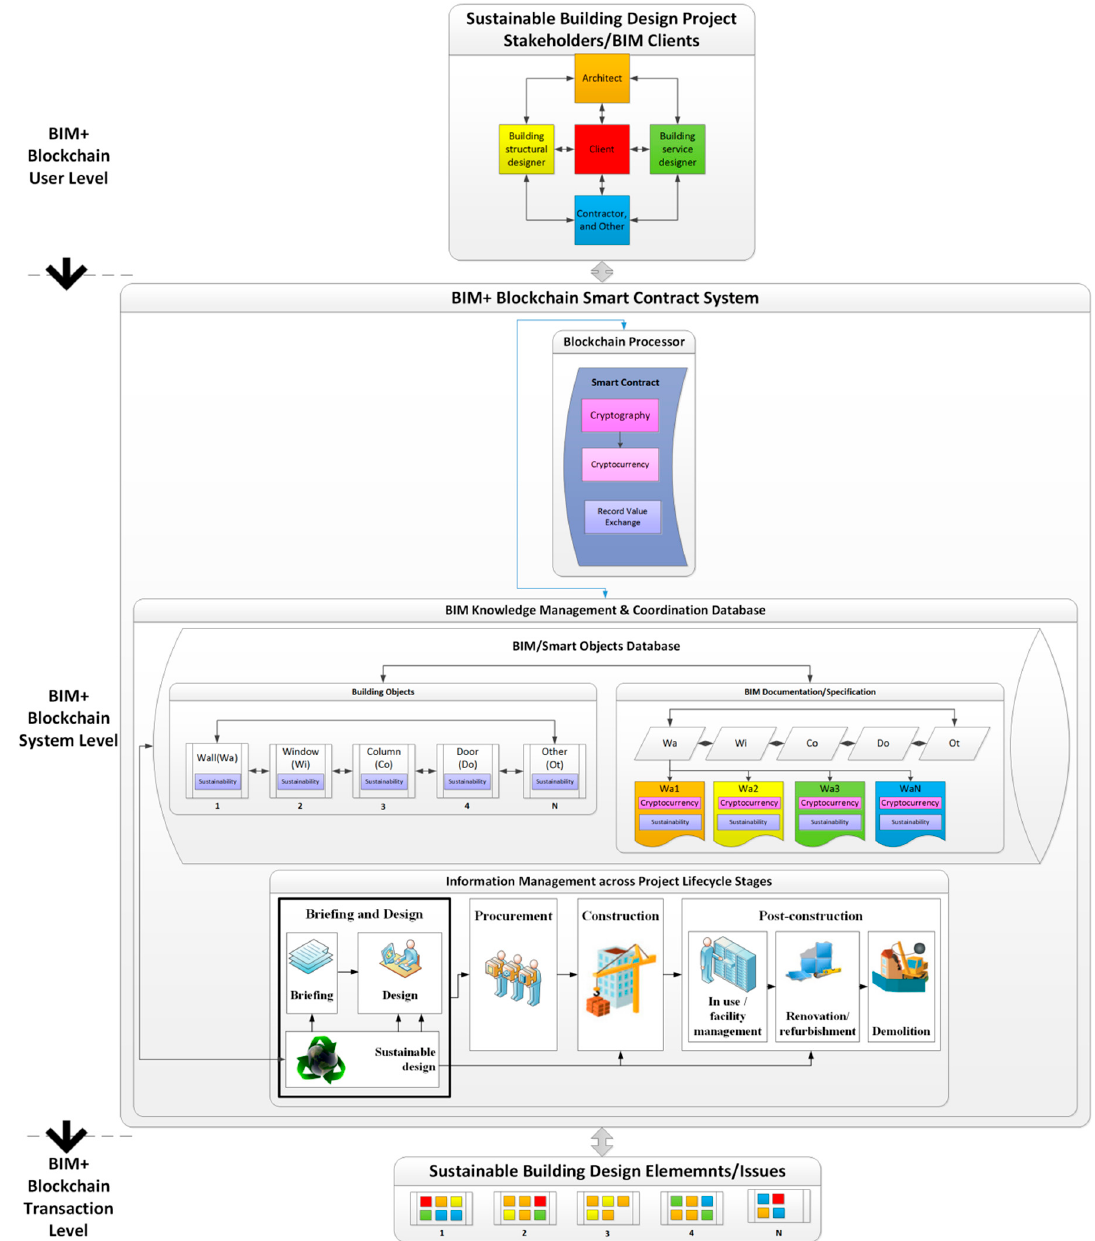
Figure 9. The Low Level of BIM + BC for Sustainable Building Design Information Management Framework (devised by the authors).